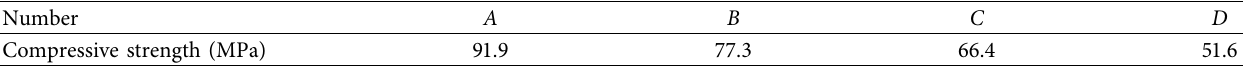
Table 2: Results of block’s compressive